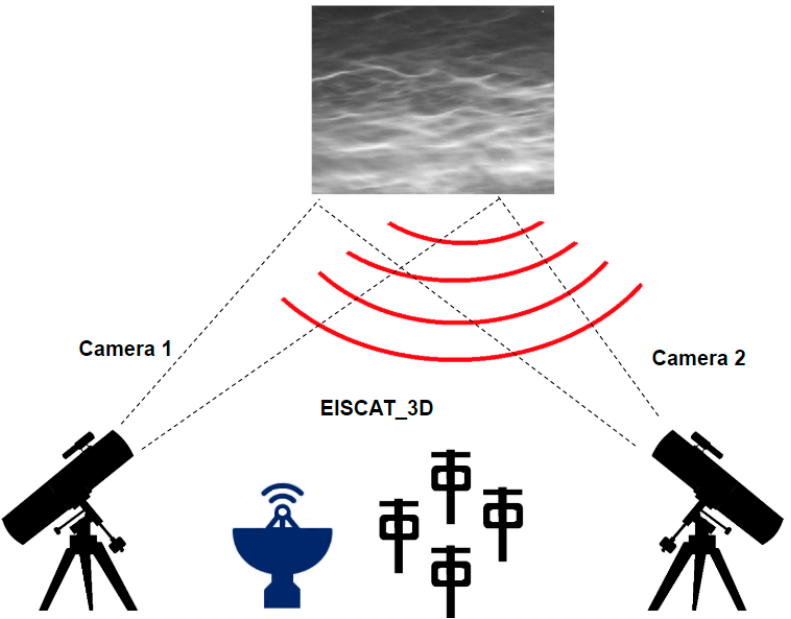
Figure 3. Framework for the analysis.